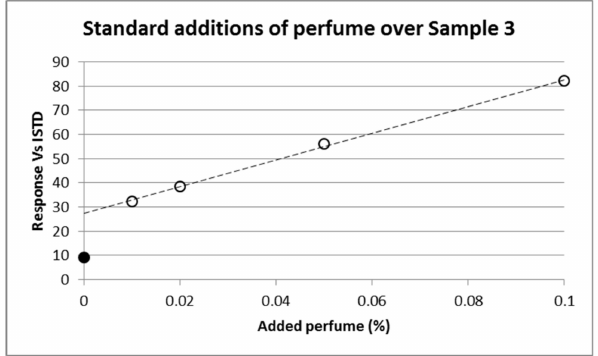
Figure 3. Standard addition to Sample 3 shells, measured by SPME-GC-MS. Filled circle represents the point of zero addition, clearly deviating from the linear perfume adsorption behaviour (dotted line) obtained by standard